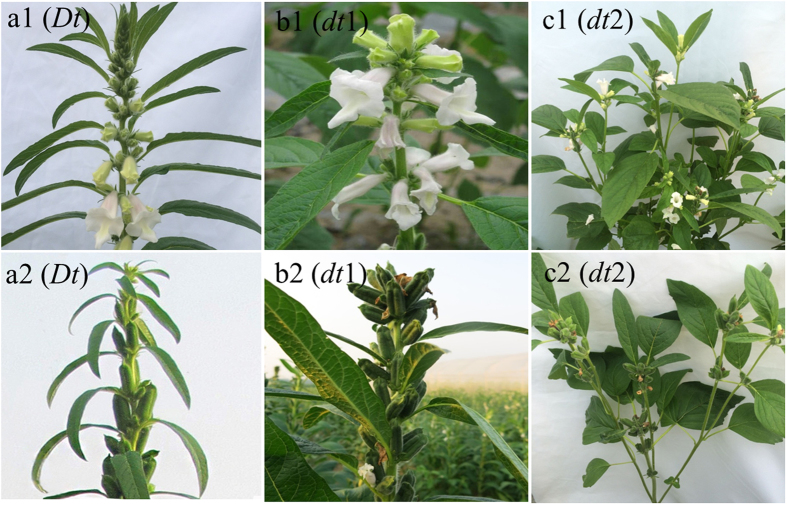
Three inflorescence meristem development phenotypes in sesame.The top and bottom photographs show the stem apexes of three genotypes at flowering and maturity, respectively. (a1,a2) Show the indeterminate genotype Dt (the wild type). (b1,b2) Show Yuzhi DS899, a determinate type 1 genotype (dt1) with a terminal flower (or capsule) cluster at the shoot apex. (c1,c2) Show 08TP092, a determinate type 2 genotype (dt2) with a terminal flower (or capsule) cluster at apex of each shoot. In dt2 only 2–3 capsule nodes are formed on both the main stem and each lateral branch.